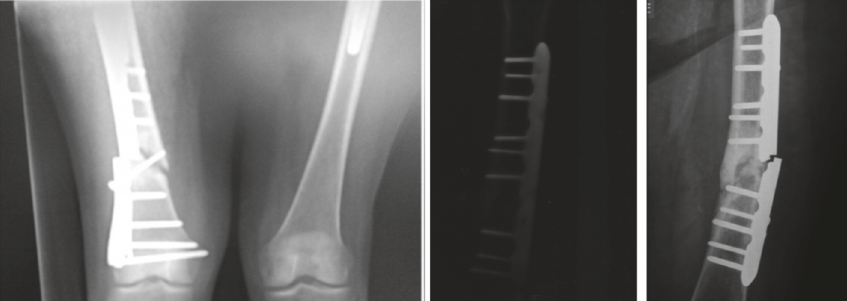
Figure 8: Bone and the failed supracondylar plates before and after being fractured. Copyright @Elsevier, reproduced with permission from Elsevier [61, 66].